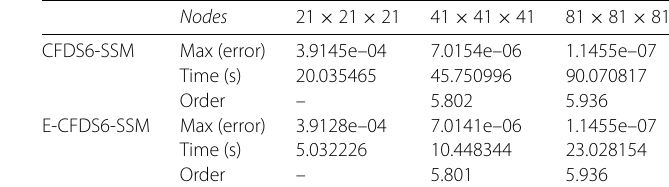
Table 9 The convergence order and computational time for SP 6 at t = 1 Nodes